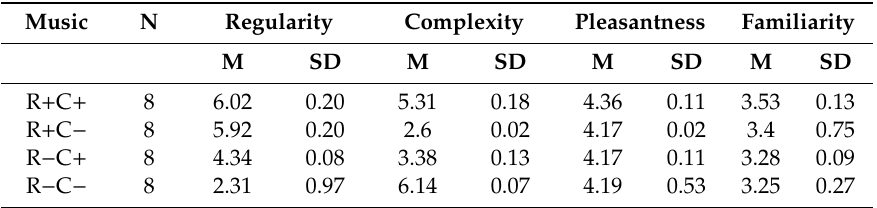
excerpts. The sets were specified as combinations of either high regularity or low regularity (R − ) (R + ) with both high complexity (C + ) and low complexity (C −